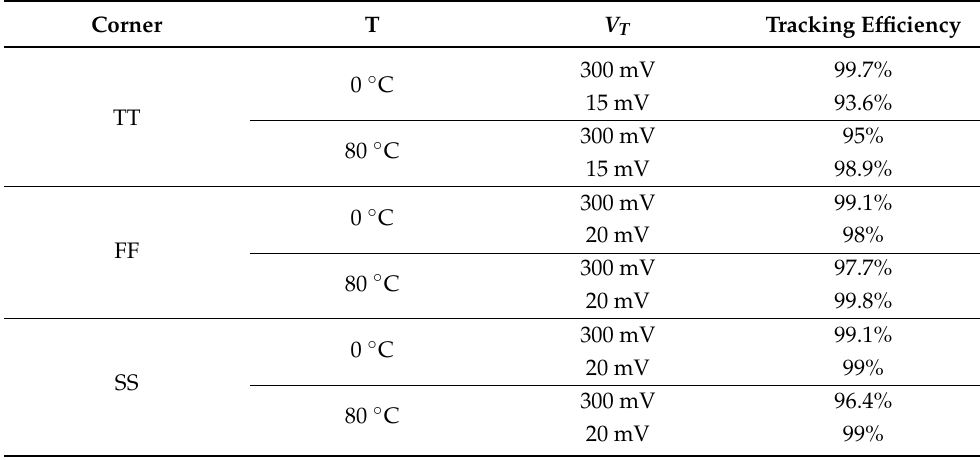
Table 2. Tracking efficiency under different corners and temperatures.